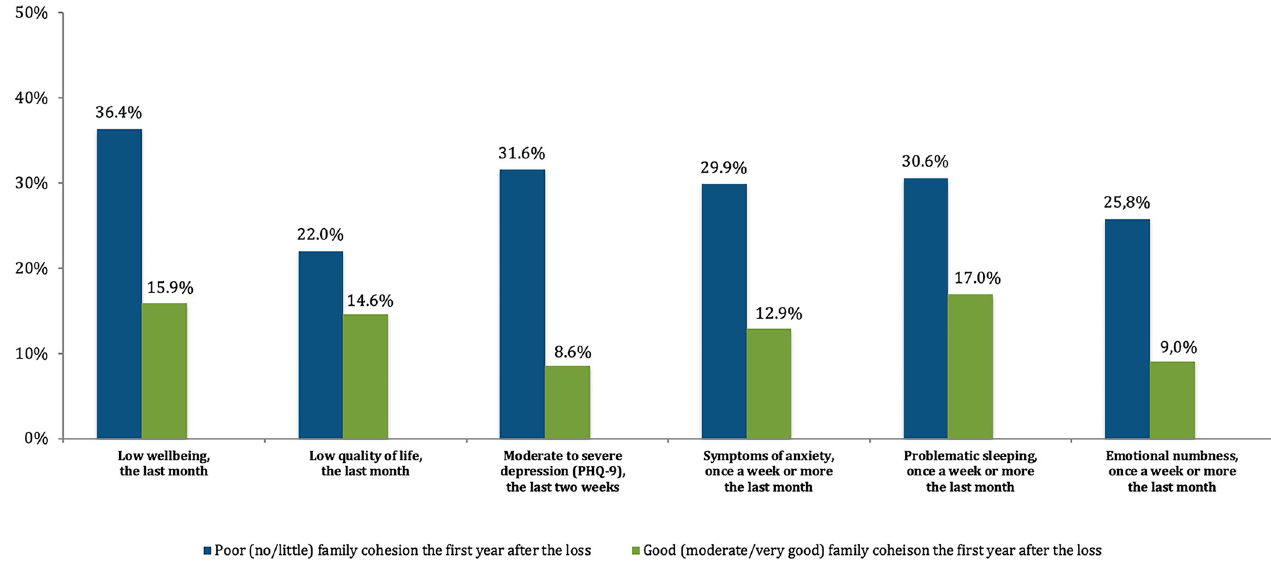
Fig 1. Prevalence of long-term negative health-related outcomes among cancer-bereaved young adults (six to nine years post loss) in relation to self- reported family cohesion the first year after the death of a parent as a teenager. Note, for graphical reasons, only the frequencies between 0% and 50% are